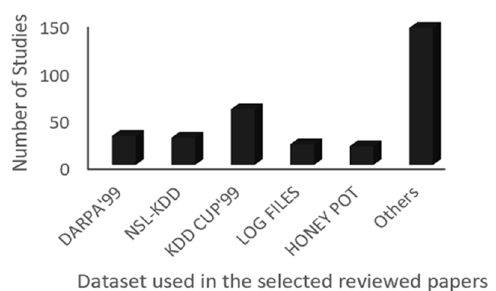
Figure 5. Data set used with supervised Machine Learning (ML) approaches.